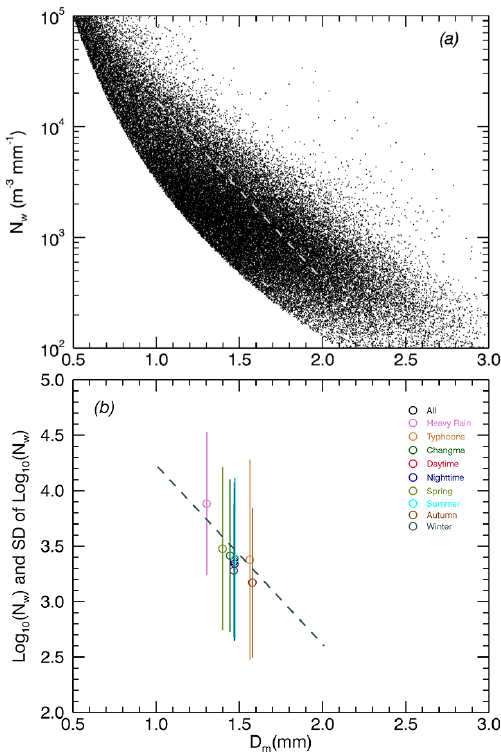
Figure 5. (a) Scatter plot of 1min D m and N w for the 10 rainfall categories with respect to stratiform rainfall data. The broken grey line represents the average line as defined by Bringi et al. (2003). (b) Scatter plot of mean D m and log 10 (N w ) values of the 10 rainfall categories with respect to stratiform rainfall; these mean values for each rainfall type are shown as circle symbols. The vertical line represents ± 1 σ of log 10 (N w ) for each category.